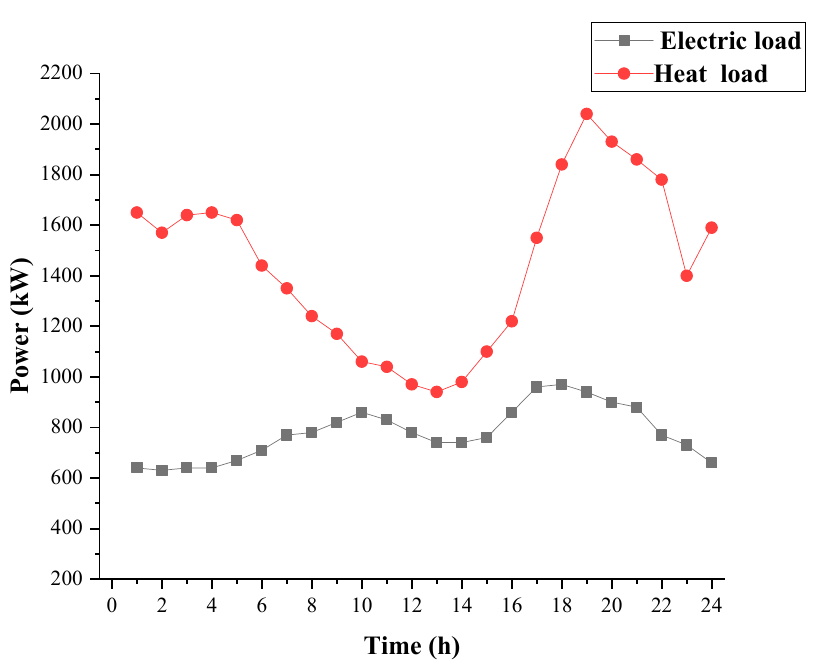
Figure 5. EH electricity–heat demand under base price. Table 2. Proportion of different types of loads in